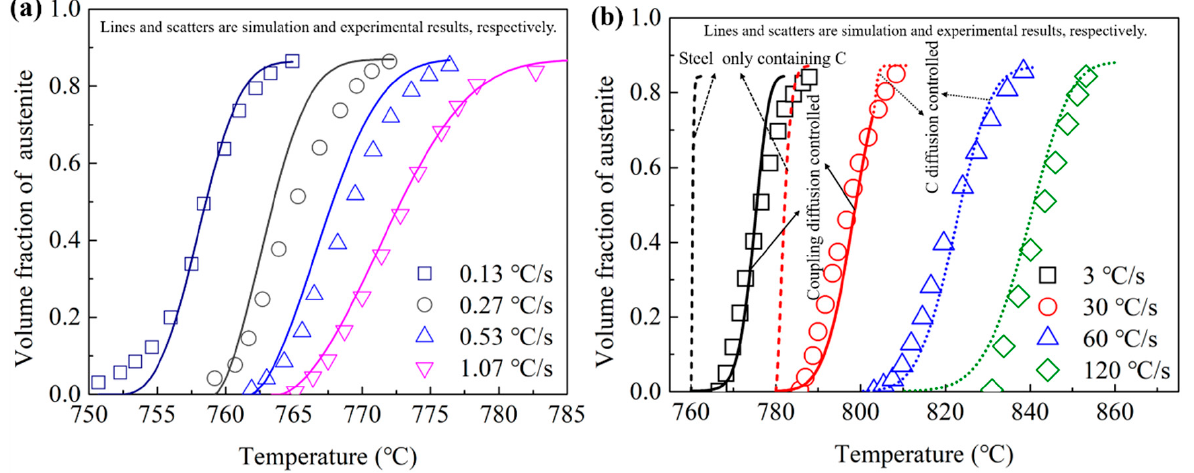
Figure 8. Comparisons of the austenitization kinetics between the experimental and cellular automata simulation results for the heating rate of ( a ) 0.13, 0.27, 0.53 and 1.07 °C/s; ( b ) 3, 30, 60 and 120 °C/s.